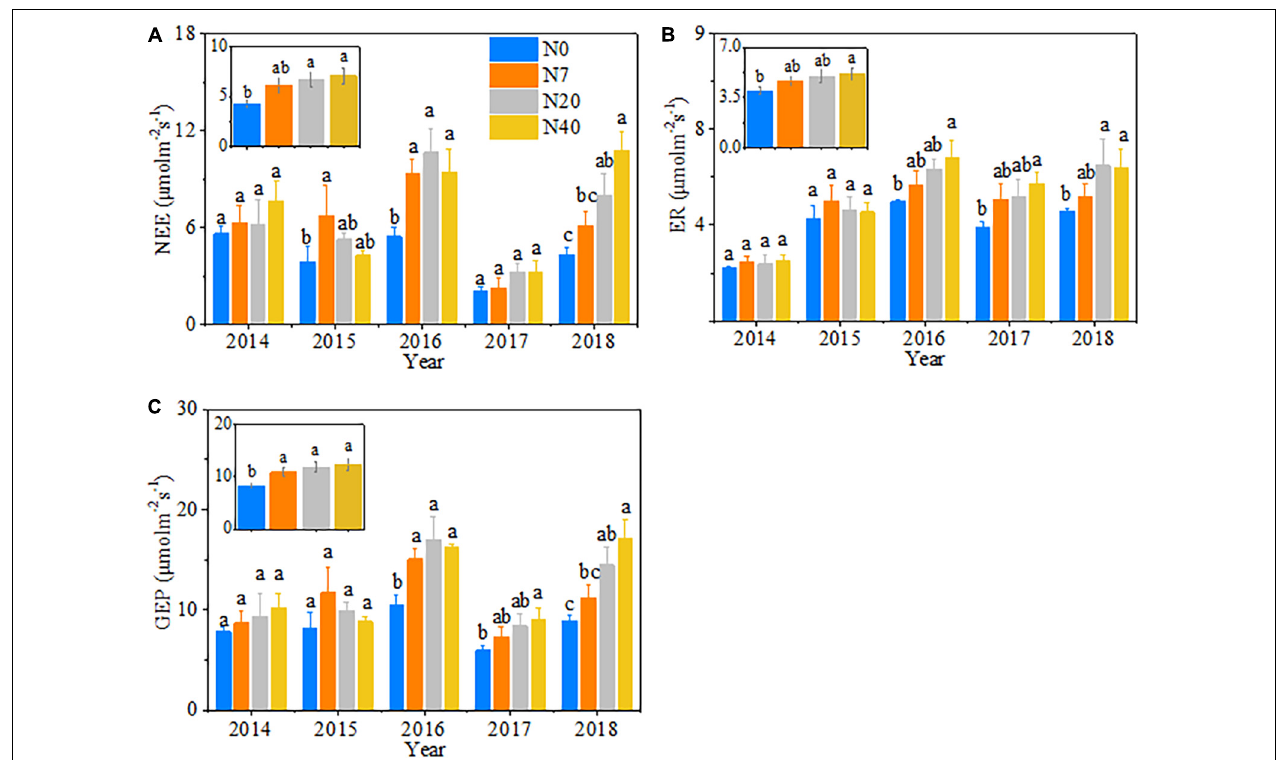
FIGURE 5 | The changes in (A) net ecosystem carbon exchange (NEE), (B) ecosystem respiration (ER), and (C) gross ecosystem productivity (GEP) with increasing N addition from 2014 to 2018. N0–N40: expressed as control, 0, 7, 20, and 40 kg N ha − 1 year − 1 . The error bars represent the standard error (SE). Different lowercase letters indicate significant differences ( p < 0.05) among different N-addition